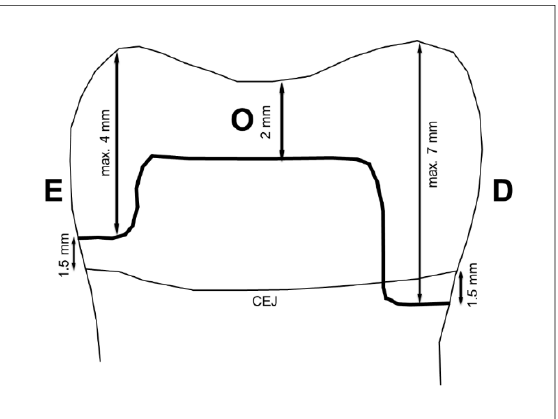
Figure 1. Cavity design and cavity dimensions (arrows); E = proximal box located within enamel; O = occlusal cavity; D = proximal box cervically located in dentin; CEJ = cementoenamel